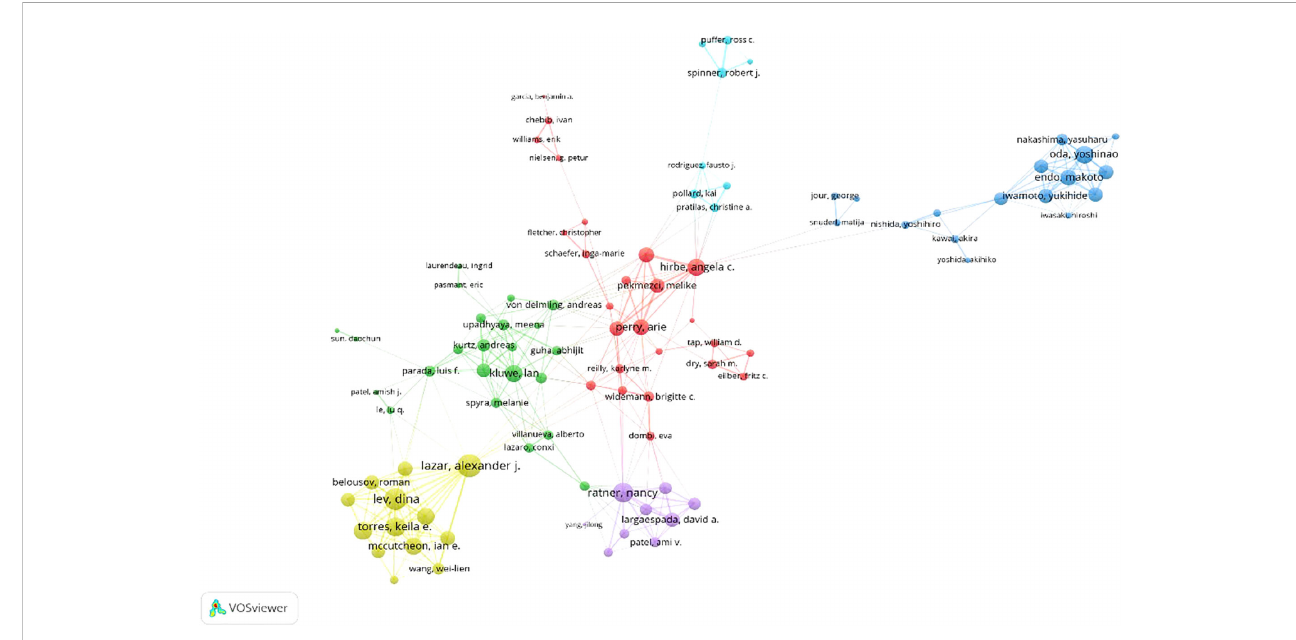
FIGURE 2 An overview of the co-authorship network in MPNST research VOSviewer.